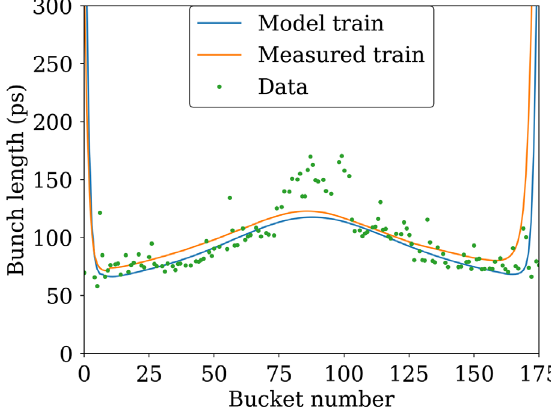
FIG. 3. Comparison of the predicted bunch lengths for different train current profiles with measured values.